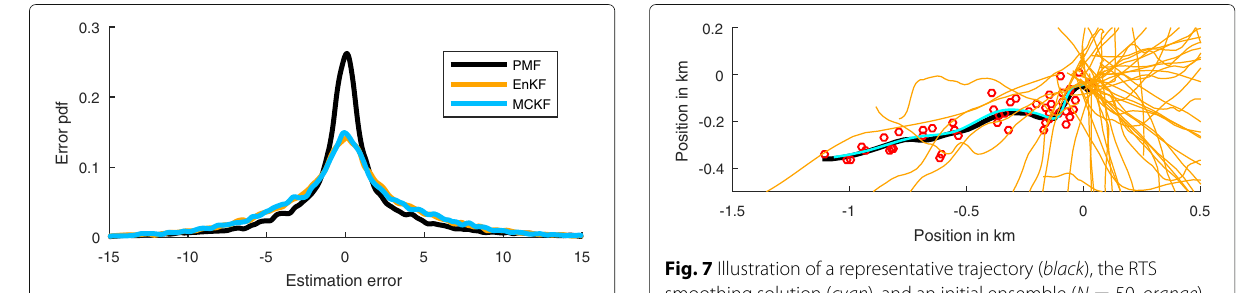
Fig. 6 Density of the estimation errors obtained from 100 Monte Carlo runs with 151 time steps each